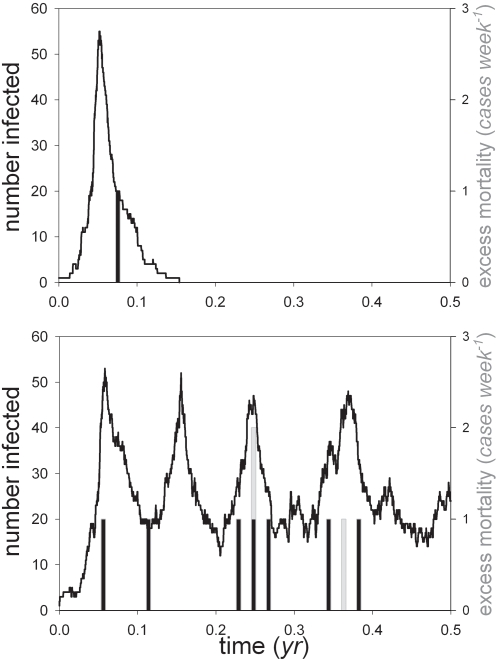
Simulations of an epidemic in a population of 106 individuals when the decision whether or not to take antiviral drugs is determined by the critical force of infection (Figure 3).The top and bottom panel show representative simulation runs in case of low (ρ = 1 (yr
−1)) and high (ρ = 6 (yr
−1)) rates of non-compliance, respectively. Other parameters are as in Table 1.